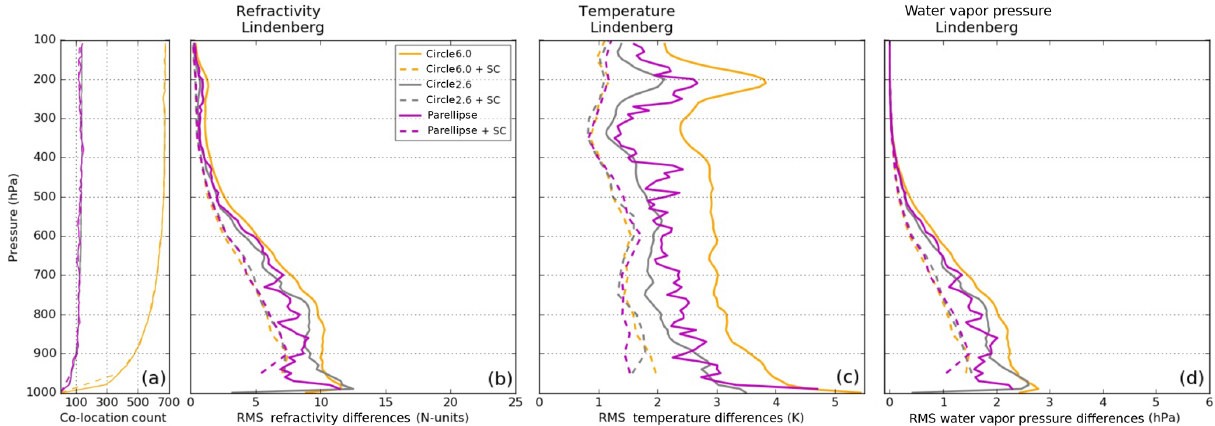
Figure 5. RMS differences for RO–RS co-locations at Lindenberg, 2014. RMS differences with ellipse method only (solid; large circle: orange; small circle: grey; ellipse: magenta) and RMS differences with ellipse method and sampling correction (dashed, abbreviated as SC) are shown for all three variables: (b) refractivity, (c) temperature, and (d) water vapor pressure. The number of pairs within each ellipse (solid) and ellipse plus sampling correction (dashed) is shown in panel (a) .